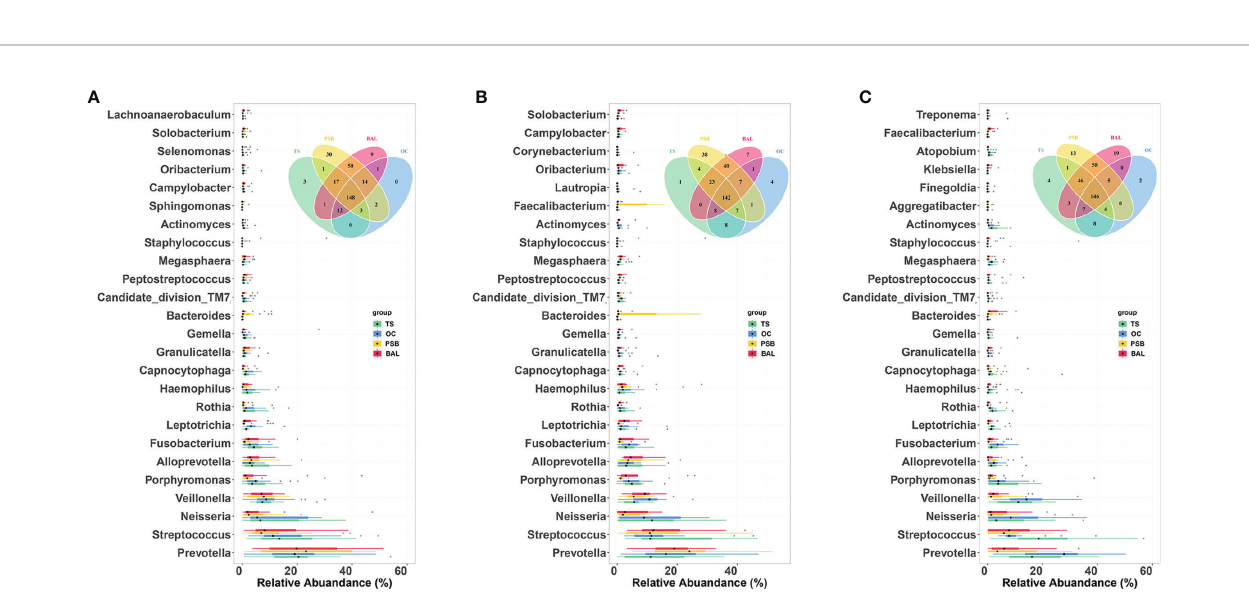
FIGURE 4 | Comparison of predominant microbial genera at four biogeographic sites in the NMTT (A) , SGC (B) and SCC (C) groups. Box plots show the relative abundance and signi fi cance of the most signi fi cant genera in microbiota at each site. The center point denotes the median. Points outside the whiskers represent outlier samples. Venn diagram in each panel illustrates overlap of genera in microbiota among the OC, TS, trachea, and lung alveoli